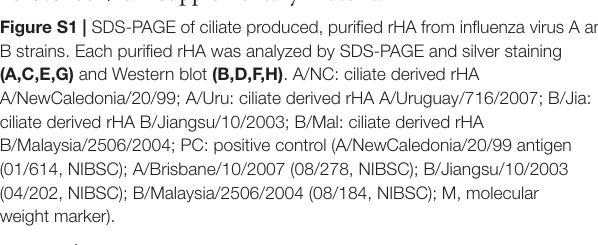
Figure S1 | SDS-PAGE of ciliate produced, purified rHA from influenza virus A and B strains. Each purified rHA was analyzed by SDS-PAGE and silver staining (A,C,E,G) and Western blot (B,D,F,H) . A/NC: ciliate derived rHA A/NewCaledonia/20/99; A/Uru: ciliate derived rHA A/Uruguay/716/2007; B/Jia: ciliate derived rHA B/Jiangsu/10/2003; B/Mal: ciliate derived rHA B/Malaysia/2506/2004; PC: positive control (A/NewCaledonia/20/99 antigen (01/614, NIBSC); A/Brisbane/10/2007 (08/278, NIBSC); B/Jiangsu/10/2003 (04/202, NIBSC); B/Malaysia/2506/2004 (08/184, NIBSC); M, molecular weight marker). Table S1 | Growth and purification of different rHA